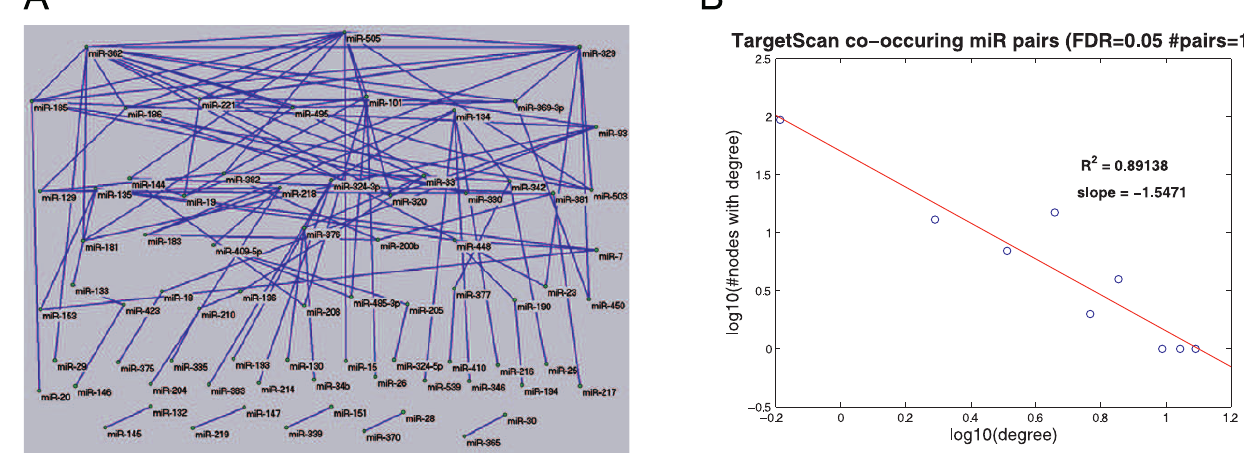
Figure 3. miR Co-Occurrence Network in the TargetScan Dataset (A) The TargetScan miR co-occurrence network, at FDR level of 0.05. A node represents a miR and an edge connects between pairs of miRs with significant rate of co-occurrence. The nodes in the figure are arranged from most highly connected on the top, to most lowly connected, on the bottom. For interactive viewing of the network, using Pajek (http://vlado.fmf.uni-lj.si/pub/networks/pajek/), see Datasets S1 and S2. (B) Degree distribution in the TargetScan miR combinatorial regulation network (co-occurring miR pairs that passed FDR of 0.05).